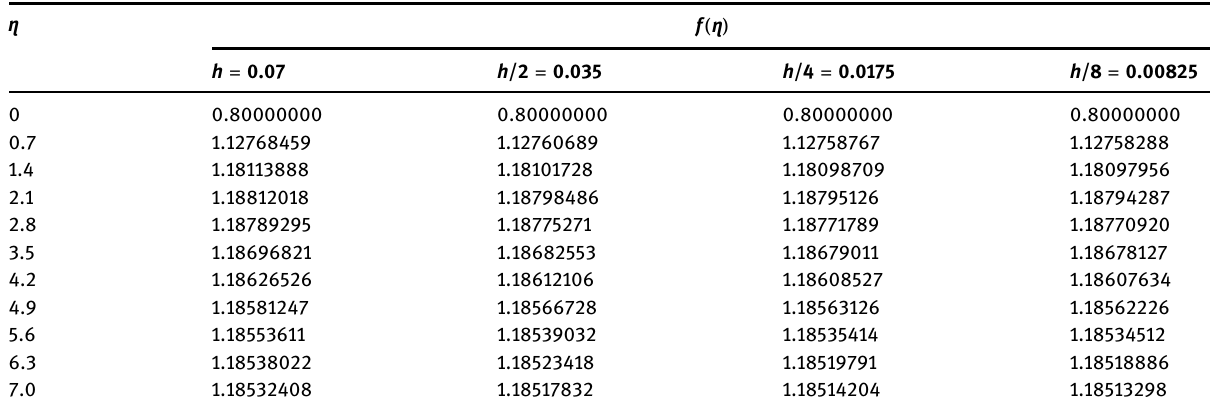
Table 4: Convergence of numerical results for ( ) f η with step - size η for